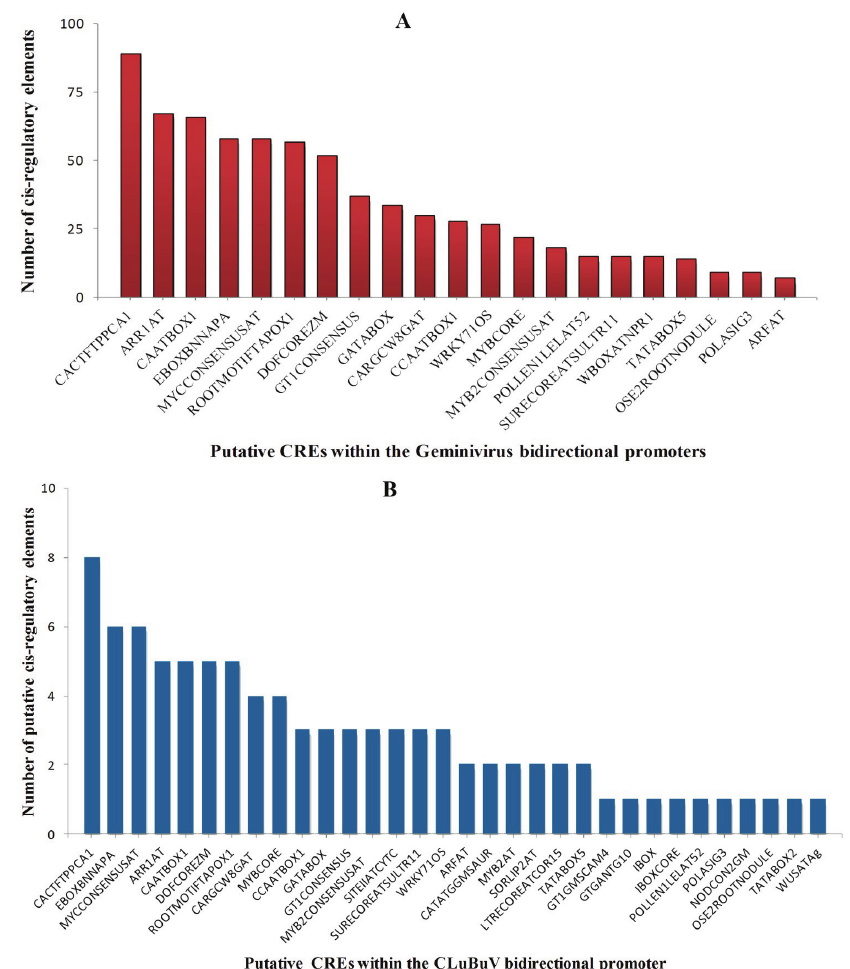
Figure 5. ( A ) Occurrence of the top 21 CREs with a total occurrence in 12 promoters; ( B ) Occurrence of 32 CREs distributed in the CLCuBuV bidirectional